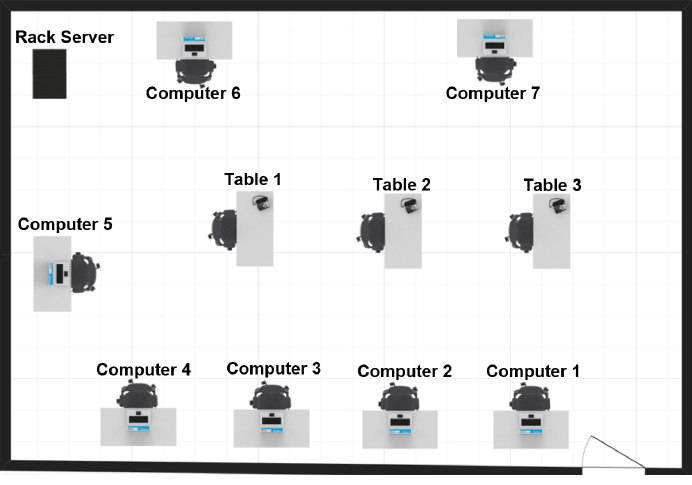
Figure 6. Computer